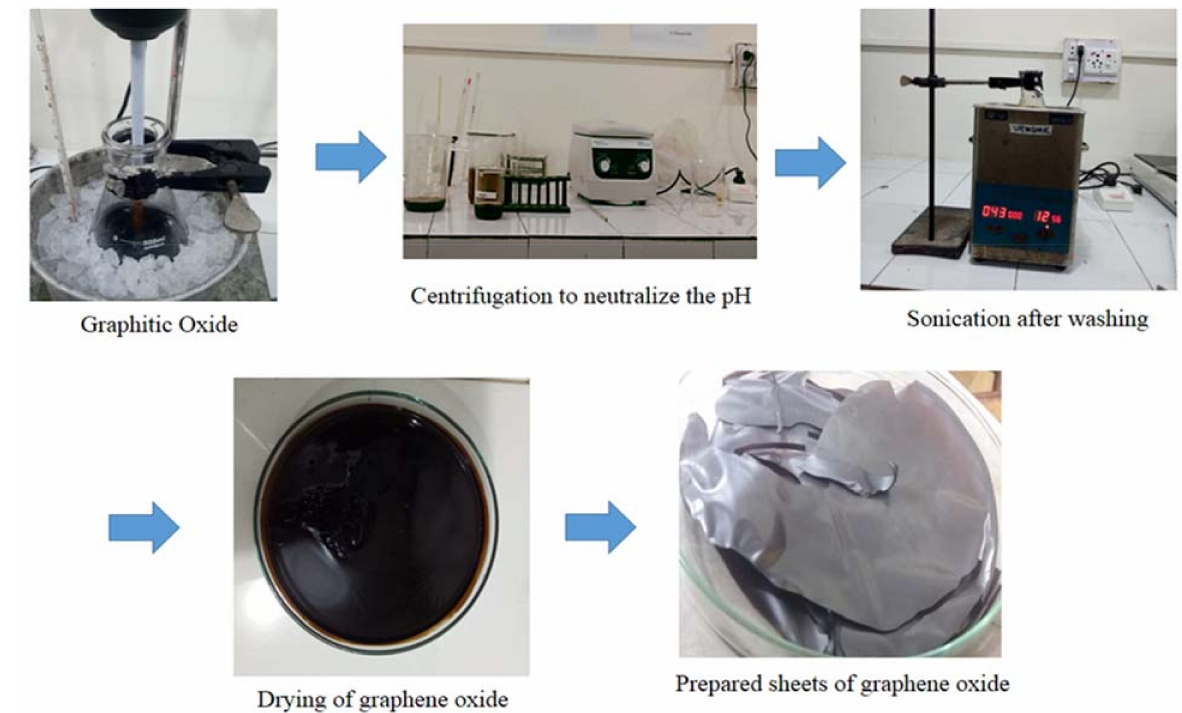
Figure 1. Schematic representation of the synthesis of graphene oxide.